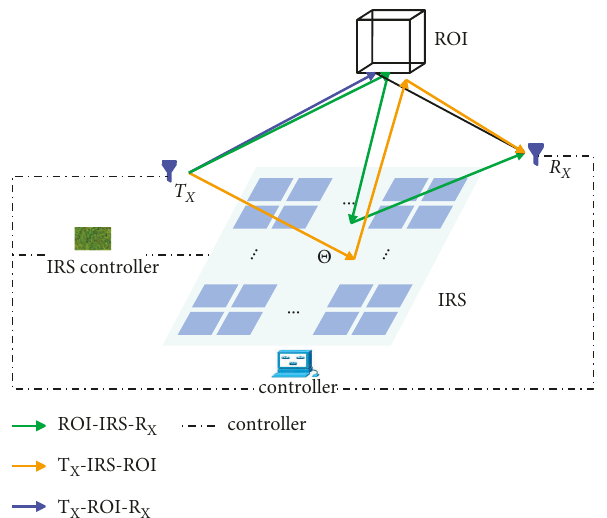
Figure 5: Schematic diagram of the use of centralized smart reflectors (separate IRS